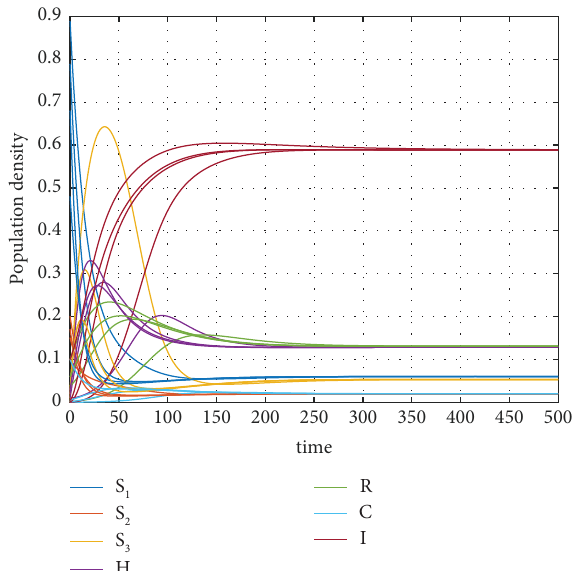
Figure 7: Evaluation of model (1), R